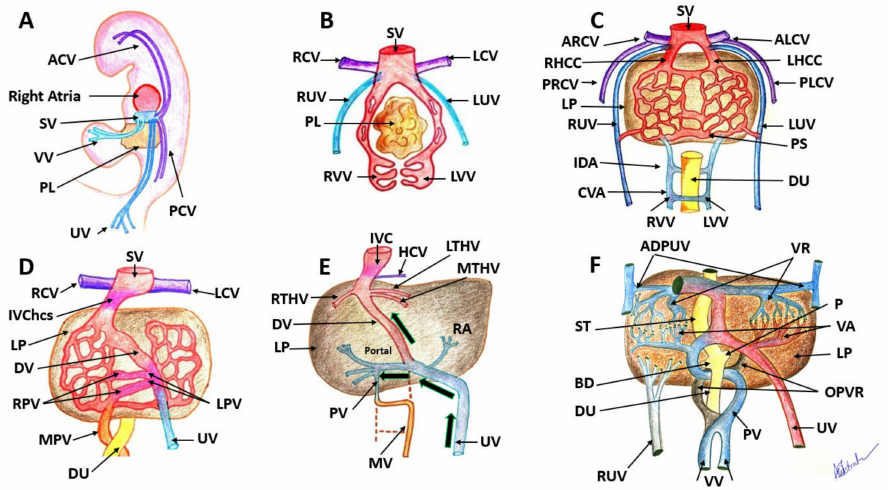
Figure 1. Embryological development of the human venous system. ( A ): The embryo demonstrates the development of paired sets of ‘vitelline’ and ‘umbilical’ veins in its fifth week, which initially drain the yolk sac and allantois. ( B ): At 4 weeks there are three symmetric paired veins: the umbilical veins, vitelline veins and cardinal veins. All three systems converge into the sinus venosus. ( C ): Liver cords develop into the septum transversum and interrupt the cranial portion of the umbilical and vitelline veins. ( D ): this is an asymmetric stage with the intrahepatic anastomosis between umbilico–portal and –ductus venosus systems. ( E ): Changes in the VVs and changes in the UVs continue. Only the most caudal and the most cranial segments of this portion of the VVs will persist. ( F ): Small venous branches, named venæ advehentes, convey the blood from the subhepatic anastomosis to the sinusoidal plexus; small venous vessels named venæ revehentes, drain the blood of the sinusoidal plexus into the subdiaphragmatic anastomosis. SV: sinus venosus, VV: vitelline veins, PL: primordial liver, UV: umbilical veins, PCV: posterior cardinal veins, ACV: anterior cardinal veins, RUV: right umbilical vein, LUV: left umbilical vein, RVV: right vitelline vein, LVV: left vitelline vein, ARCV: anterior right cardinal vein, ALCV: anterior left cardinal vein, DU: duodenum, PS: portal sinus, IDA: intermediate dorsal anastomosis, CVA: caudal ventral anastomosis, PRCV: posterior right cardinal vein; PLCV: posterior left cardinal vein; RHCC: right hepatic common cardinal vein; IVChcs: inferior vena cava hepatocardiac segment; RPV: right portal vein; LPV: right portal vein; UV: umbilical vein; MPV: main portal vein; LP: liver parenchyma; IVC: inferior vena cava; PV: portal vein; MV: mesenteric vein; RA: ramus angularis; RTHV: right terminal hepatic vein; MTHV: median terminal hepatic vein; LTHV: median terminal hepatic vein; HCV: hepatic cardialis venula; OPVR: obliterated portion of venous rings; BD: bile duct; P: pancreas; VA: venae advehentes; VR: venae revehentes; ADPUV: anterior detached portions of umbilical vein. Images from the collection of Dr Anca-Maria